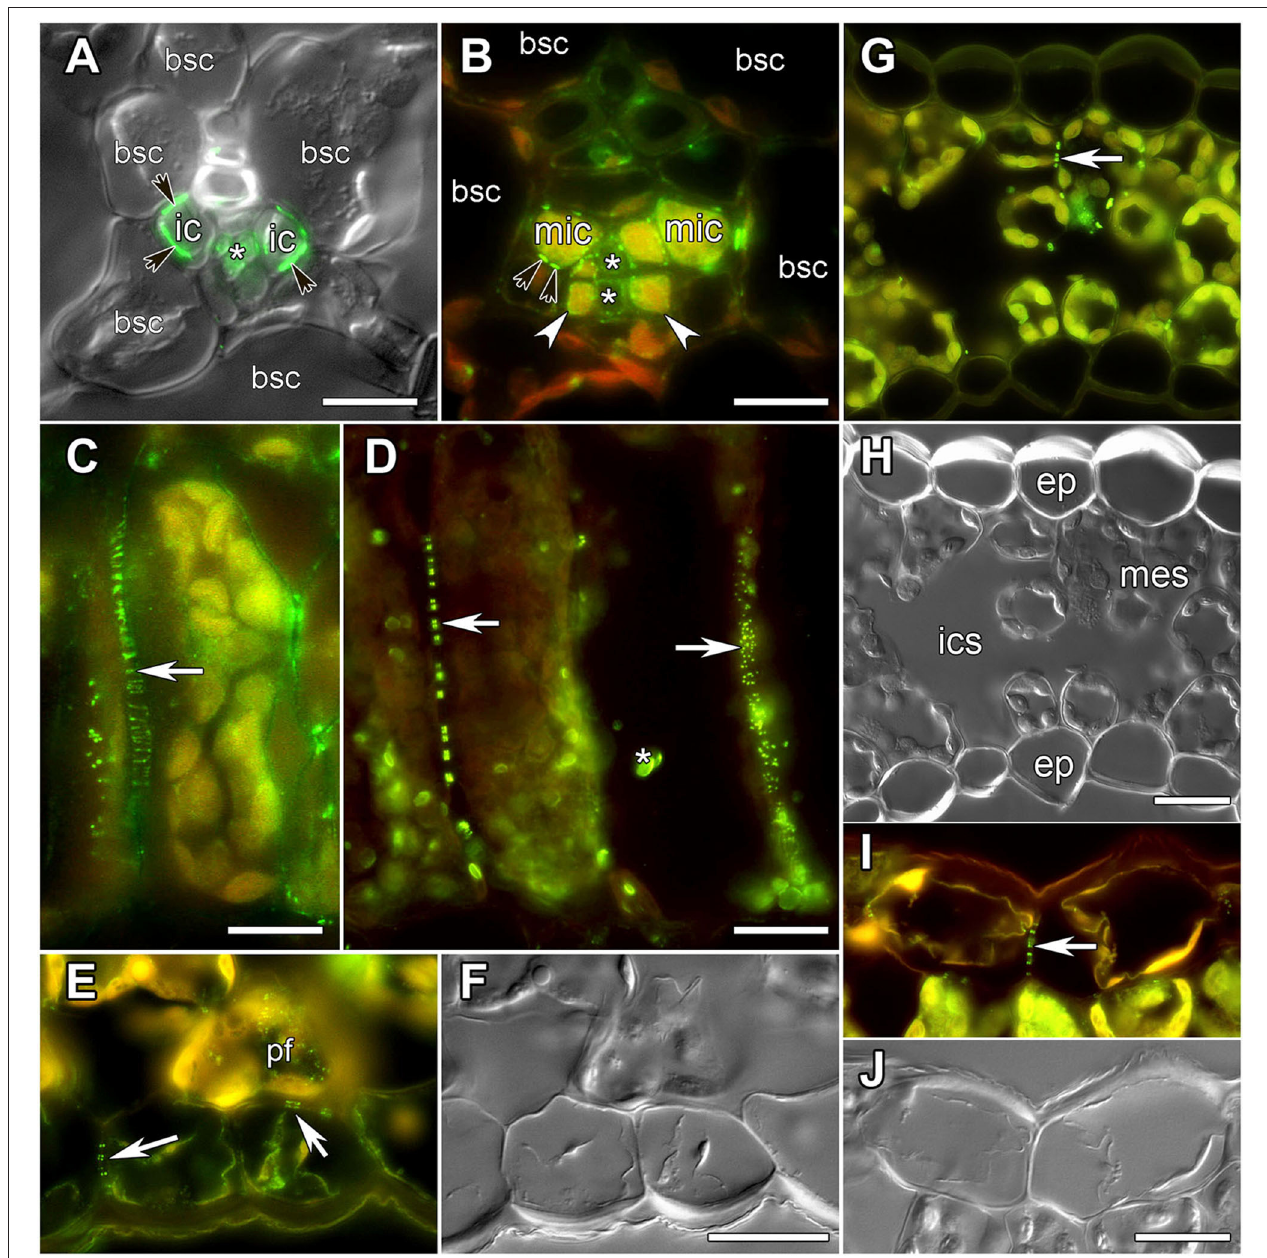
FIGURE 1 | Images of leaf sections obtained using either differential interference contrast (A,F,H,J) or epifluorescent microscopy (A – E,G,I) showing labeling of PD by immunolocalization of calreticulin (A–D) or myosin VIII (E–J) , respectively. (A,C,I,J) Alonsoa meridionalis ; (B,E,F) Asarina barclaiana ; (D) potato; (G,H) barley. (A,B) Minor veins. bsc, bundle sheath cell; ic, intermediary companion cells in A. meridionalis ; mic, modified intermediary cells in A. barclaiana ; white arrows point to transfer cells in A. barclaiana ; black arrows point to PD fields between intermediary cells and bundle sheath cells in A. meridionalis and between modified intermediary cells and bundle sheath cells in A. barclaiana , respectively; asterisks mark sieve elements. (C,D) palisade mesophyll cells in A. meridionalis (C) and potato (D) . Arrow points to PD; asterisk marks non-specific chloroplast labeling in potato (D) . (E,F) Part of an A. barclaiana leaf showing the lower epidermis. Arrows point to PD; pf, pitfield. (G,H) Transverse section through a barley leaf. ep, epidermal cell; mes, mesophyll cell; ics, intercellular space; arrows point to PD. (I,J) Part of an A. meridionalis leaf showing the upper epidermis. Arrows point to PD. Size bars: 10 µ m (A,B) , 20 µ m (C–J) .